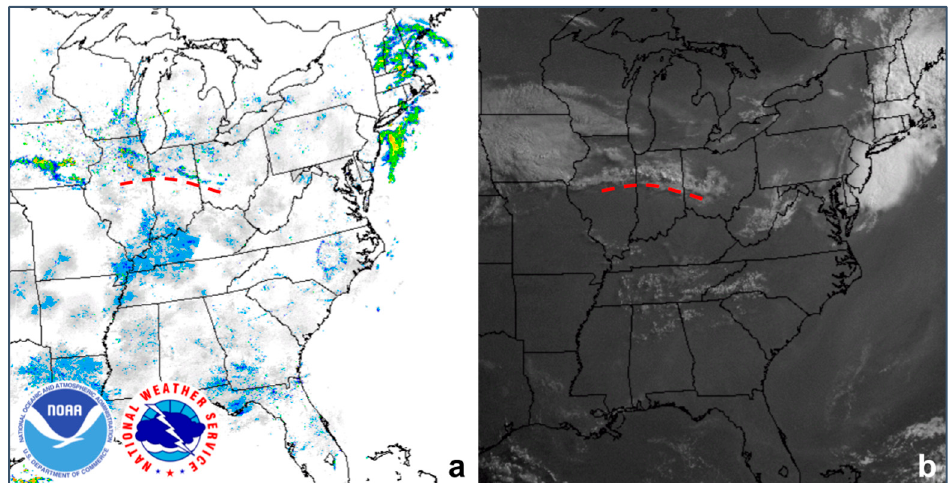
Figure 6. 12Z 29 June 2012 ( a ) observed Doppler radar and ( b ) GOES visible satellite imagery. Red dashed lines on each panel indicate leading edge of EML (or EMLF).